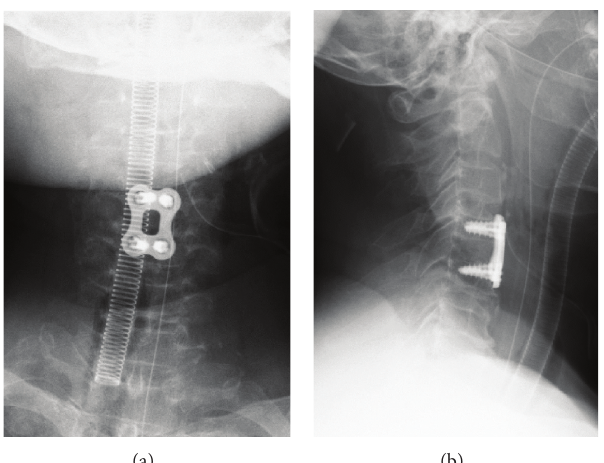
Figure 4: The final radiograms before extubation showed that ACDF was indeed performed at the correct level at C4-5. (a) Anteroposterior view and (b) lateral view.